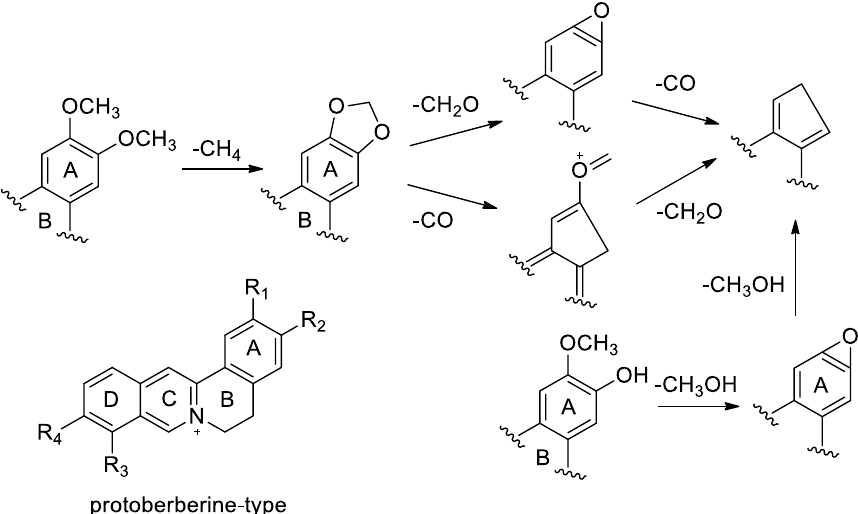
Figure 2. General MS/MS fragmentation pathways of protoberberine-type alkaloids.